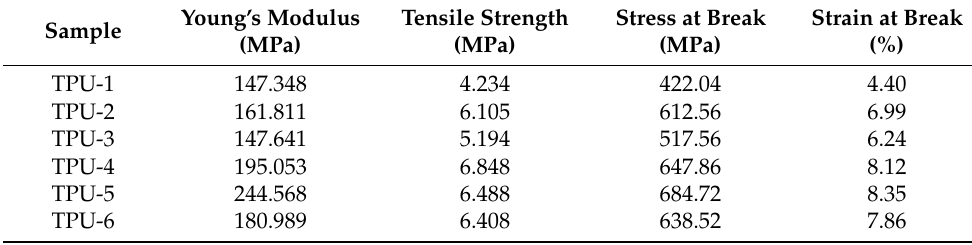
Figure 4. Stress/strain curves of the TPU Nanocomposites (a) TPU-1, (b) TPU-2, (c) TPU-3, (d) TPU-4, (e) TPU-5, and (f) TPU-6. Table 2. Mechanical features of the TPU-filler